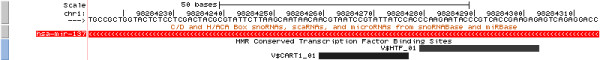
Alignment of Conserved TFBS track and Sno-miRNA track. Shown are the Conserved TFBS and sno/miRNA tracks from the UCSC Genome Browser in the region corresponding to the small hairpin microRNA precursor encoding hsa-mir-137. The Conserved TFBS track is shown at its default setting (using stringent criteria to display conserved TFBS having z-score ≥ 2.33).